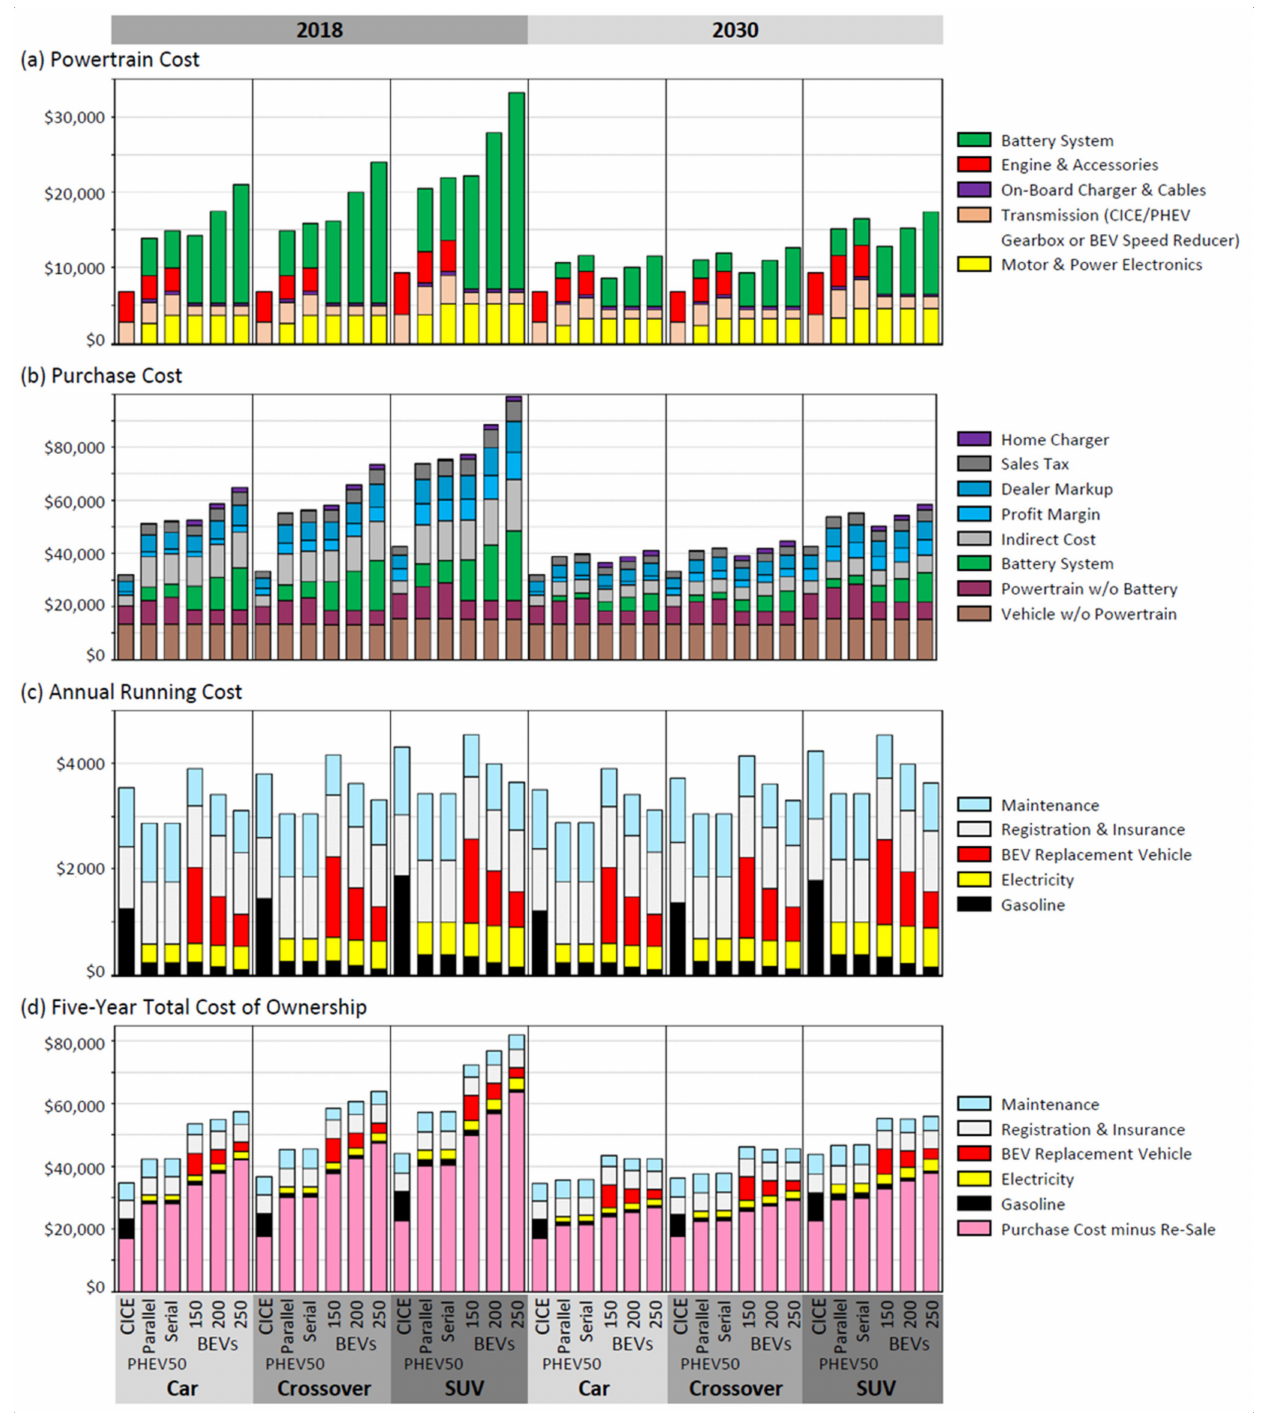
Figure 1. Baseline estimated costs of conventional internal combustion-engine (CICE) and various plug-in vehicle models for 2018 and 2030. ( a ) Cost of powertrain Only ( b ) Total purchase cost of the vehicle ( c ) Annual running cost of the vehicle ( d ) Total cost of ownership over five years (purchase cost plus running cost minus resale